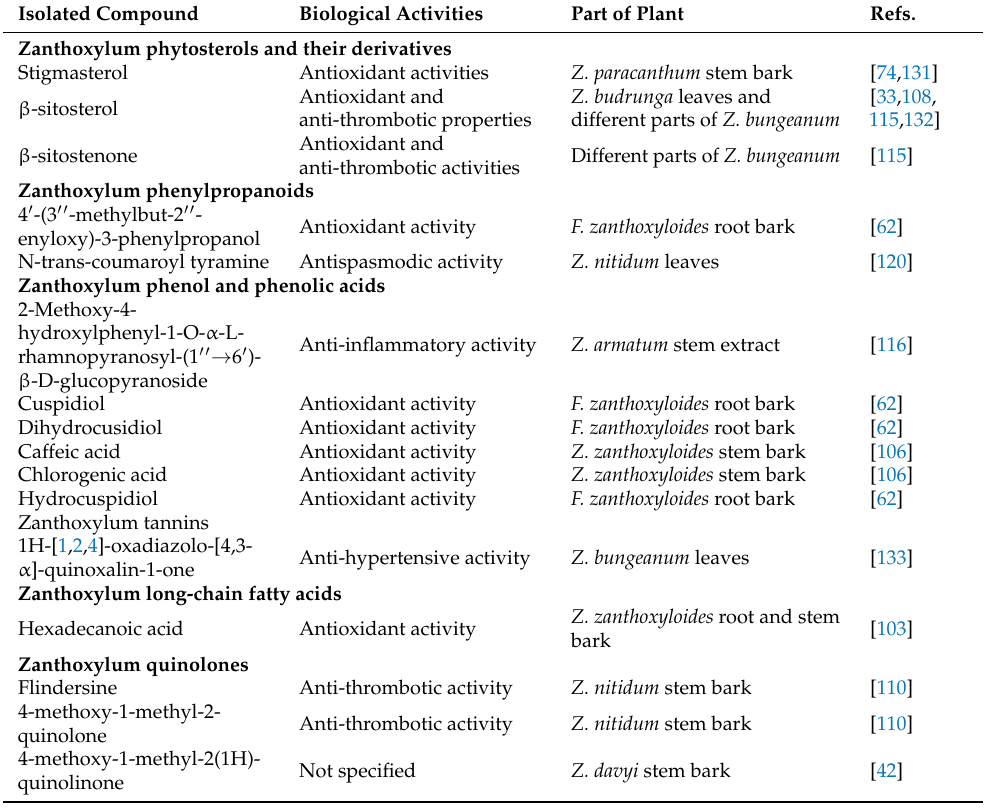
Table 8. Phytosterols and their derivatives, phenol and phenolic acids, tannins, fatty acids, phenyl- propanoids and steroid isolated from Zanthoxylum species with their biological activities.